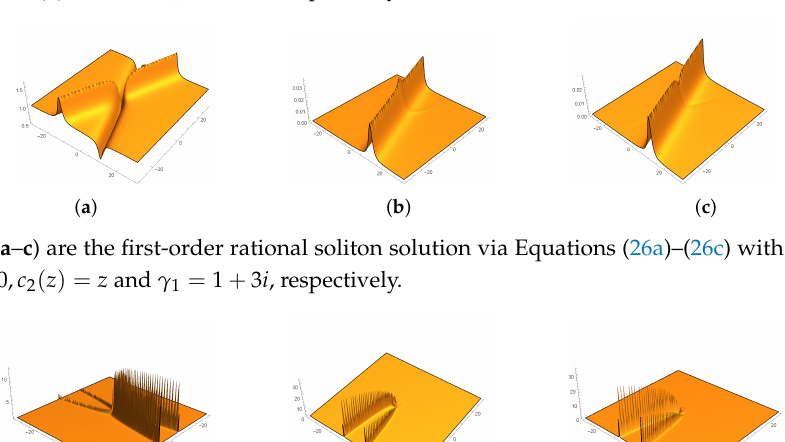
Figure 7. ( a – c ) are the first-order rational soliton solution via Equations (26a)–(26c) with ρ = 1, φ = 0, c 1 ( z ) = 0, c 2 ( z ) = z and γ 1 = 1 − 3 i , respectively.